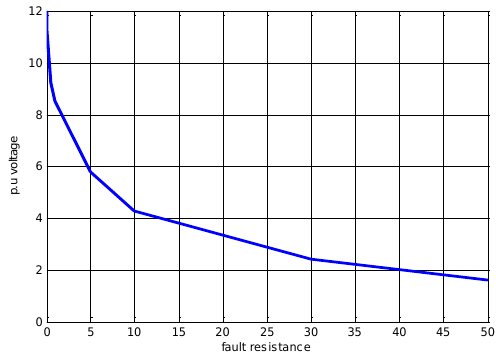
Fig. 13. Maximum instantaneous voltage for phase-c secondary to the base of fault resistance.